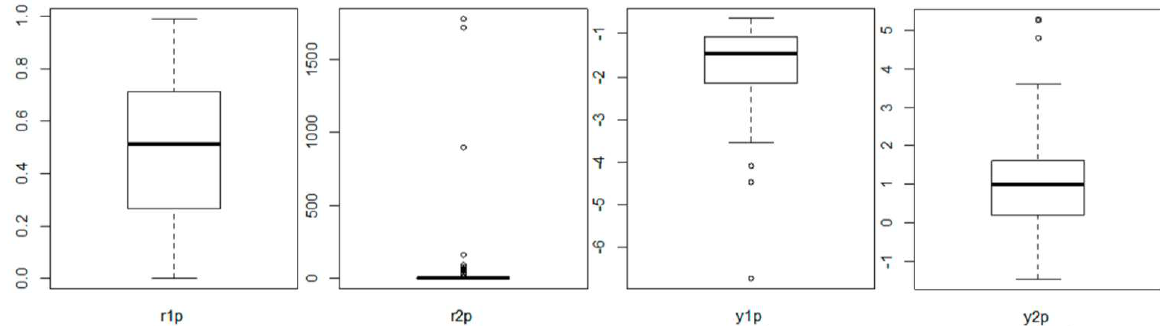
Figure 8. Box plots of standard ( r 1p , r 2p ) and compositional ( y 1p , y 2p ) financial ratios after permutation. Table 2. Skewness, kurtosis, and count of outliers of standard and compositional financial ratios before (top) and after (bottom) permutation. Skewness Kurtosis n Outliers * n Extreme Outliers ** r 1 10.48 −0.01 −1.16